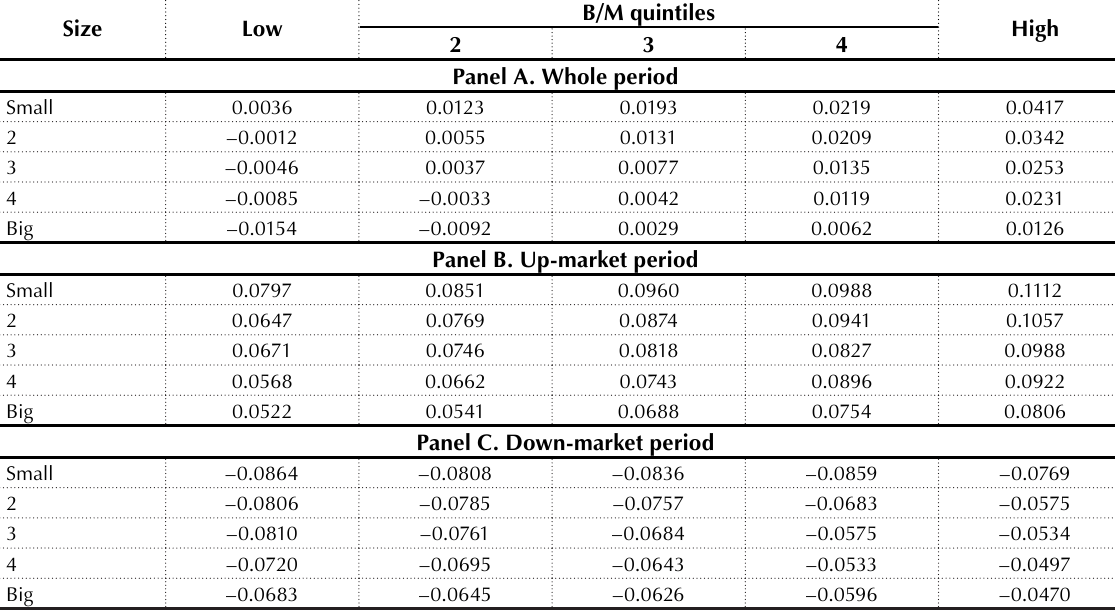
Table 3. Average equal-weighted monthly returns on double-sorted portfolios formed on size and book-to-market (B/M) quintiles from 1995 through